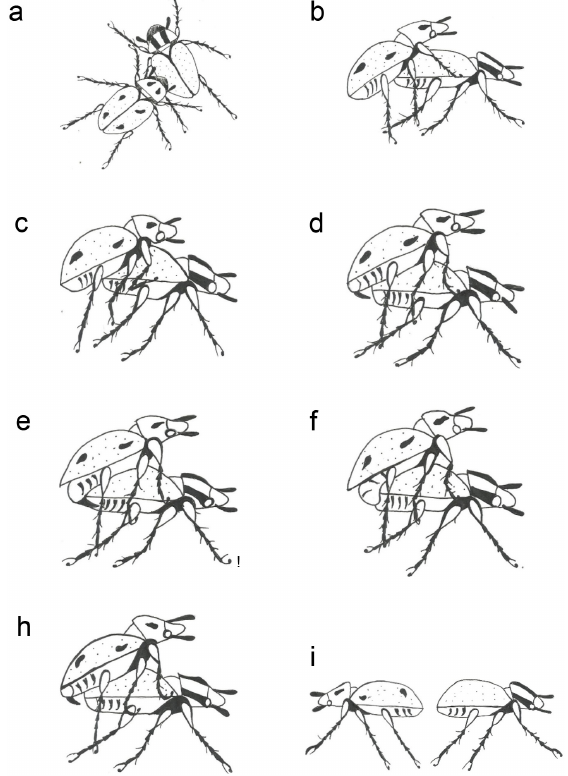
Figure 1. Cyclocephala distincta mating sequence (n = 25). a male approaches a female and rubs the antennas on her elytra; b male rises in the female; c male mounting the female; d male everts his aedeagus; e male inclines abdomen in relation to female pigidium; f copulation; g male withdraws and retracts the aedeagus; h disassembles and separation of